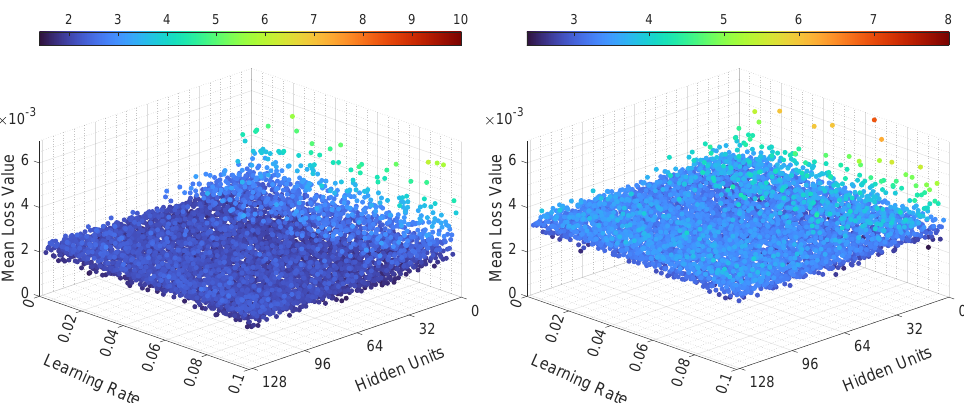
Figure 10. Illustration of the mean loss value for Experiment 3, LSTMTF ( left ) and VLSTM ( right ), using a many-to-many prediction mode.